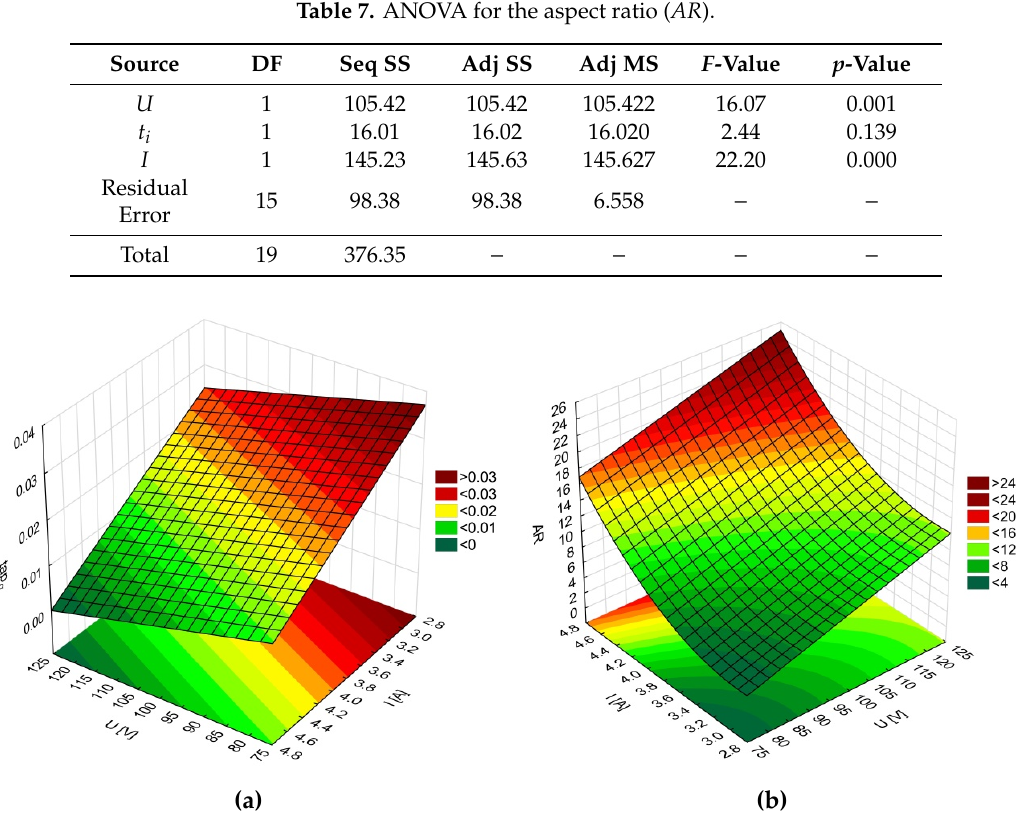
Figure 7. Relationship between the current amplitude ( I ) and the discharge voltage ( U ) and the process’s performance: ( a ) taper angle ( tap α ); ( b ) aspect ratio ( AR ); t i = 550 μs.